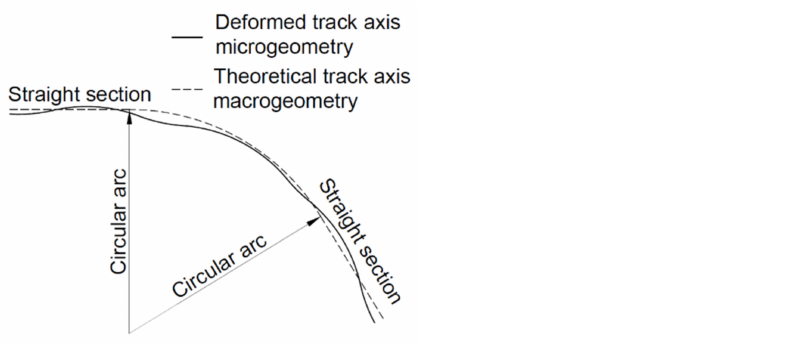
Figure 1. Relationship between railway track macro- and